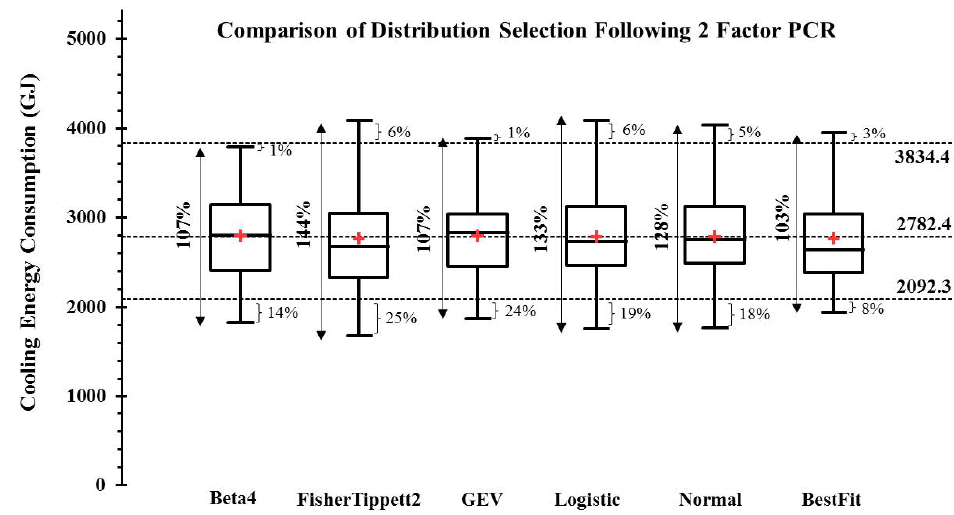
Figure 15. Cooling energy use probability density functions when following a 2 Factor Principal Component Regression model and comparing selection of First and Second input principal component distribution series used in the uncertainty propagation method.